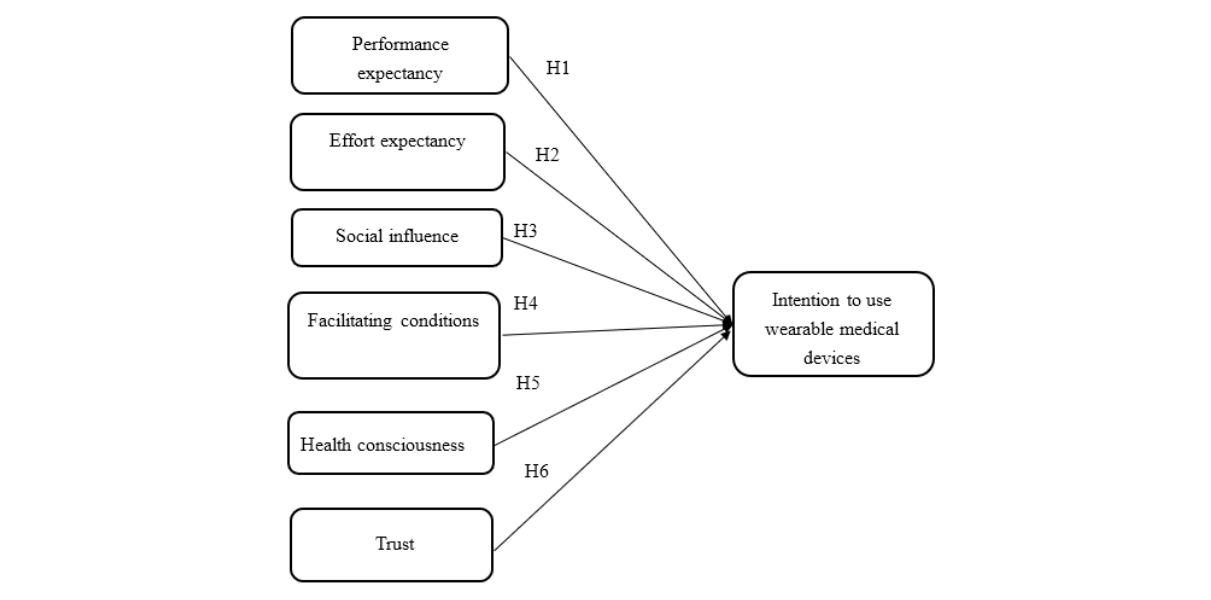
Figure 1. Research